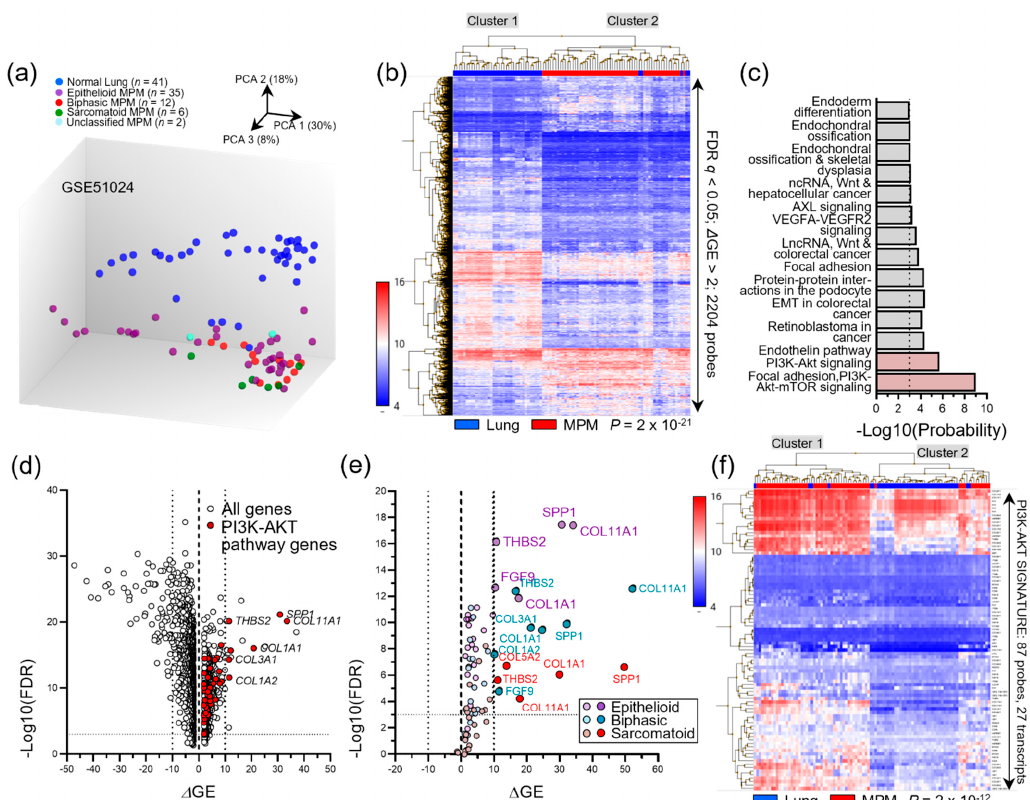
Figure 2. Transcriptional activation of the phosphoinositide 3-kinase (PI3K)-protein kinase (AKT) pathway downstream of KRAS in the Gene Expression Omnibus (GEO) MPM dataset GSE51024. Raw data of the gene expression profiles of MPM ( n = 55) and normal lung ( n = 41) tissues assessed by Affymetrix HG-U133_Plus_2 microarrays were retrieved from https://www.ncbi.nlm.nih.gov/geo/query/acc.cgi?acc=GSE51024 (accessed on 3 March 2022) and were analyzed using Affymetrix transcriptome analysis console v4.0. ( a ) Principal component analysis (PCA) plot showing color-coded individual patients (circles), percentile weight of the three principal components (%), patient numbers ( n ), and color-coded legend. ( b ) Unsupervised hierarchical clustering of all samples (columns) by 2204 probes (rows) differentially regulated in MPM and normal lung tissues. Data are presented as color- coded heatmaps of log2(signal intensities) produced via robust multi-array average normalization. FDR q , probability, false discovery rate; ∆ GE, differential gene expression, fold-change MPM over lung tissues; p , probability, hypergeometric test. ( c ) Fourteen WikiPathways statistically significantly ( p < 0.001, FDR) differentially regulated in the 2204 probes from ( b ). Data are presented as average WikiPathway significance (bars) and threshold ( p < 0.001; dotted line). Red bars denote PI3K-AKT pathways and grey bars all other pathways. ( d ) Volcano plot of probes for all genes (white circles) and of 48 probes for 27 genes of WikiPathways “phosphoinositide 3-kinase (PI3K)-protein kinase (AKT) signaling” and “focal adhesion-PI3K-AKT-mTOR signaling” (red circles; including CCNE2 , CDK6 , COL11A1 , COL1A1 , COL1A2 , COL3A1 , COL5A1 , COL6A1 , COL6A2 , COL6A3 , COMP , EFNA5 , EFNA5 , FGF18 , FGF9 , FN1 , HSP90B1 , IGF1 , IGF2 , ITGB4 , LAMA1 , PDGFD , SPP1 , THBS2 , THBS3 , THBS4 , and VTN ; hereafter called PI3K-AKT signature). ( e ) Volcano plot of differential gene expression of PI3K-AKT signature genes in the major histologic MPM subtypes. In ( d , e ), data are presented as color- coded individual probe data points (circles), thresholds of significance (dotted lines), and ∆ GE = 0 reference (dashed lines). In ( e ), light colors denote non-significant and dark colors significant probes. ( f ) Unsupervised hierarchical clustering of all samples (columns) by 48 probes for 27 PI3K-AKT signature genes (rows). Data are presented as color-coded heatmaps of log2(signal intensities) produced via robust multi-array average normalization. FDR q , probability, false discovery rate; ∆ GE, differential gene expression, fold-change MPM over lung tissues; p , probability, hypergeometric